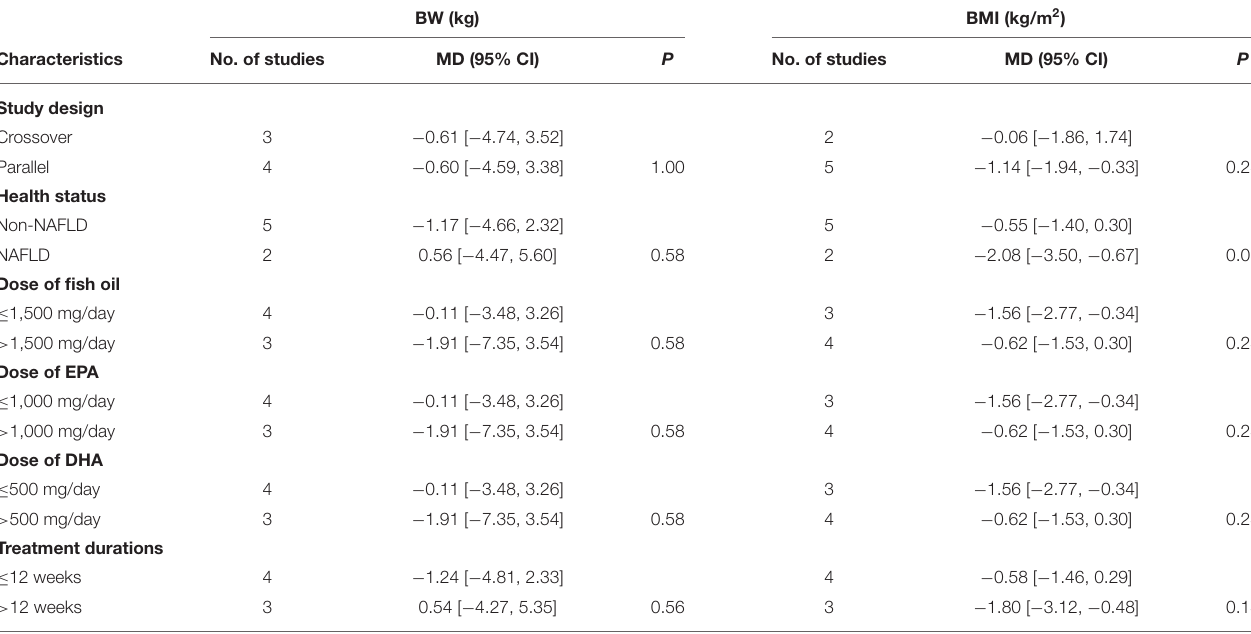
TABLE 4 | Subgroup analyses for the outcomes of BW and BMI. BW (kg) BMI (kg/m 2 )